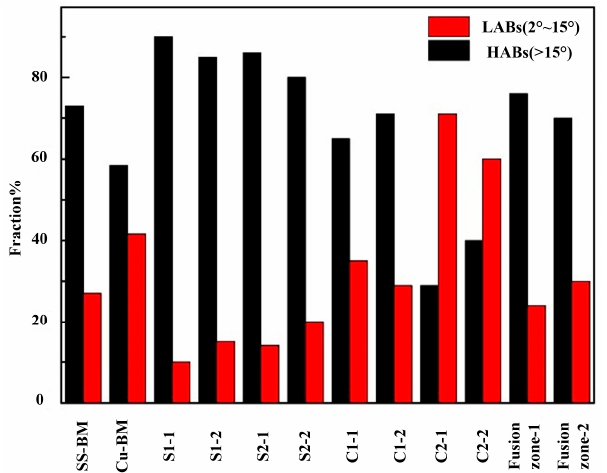
Figure 11. Grain misorientation distributions of local weld